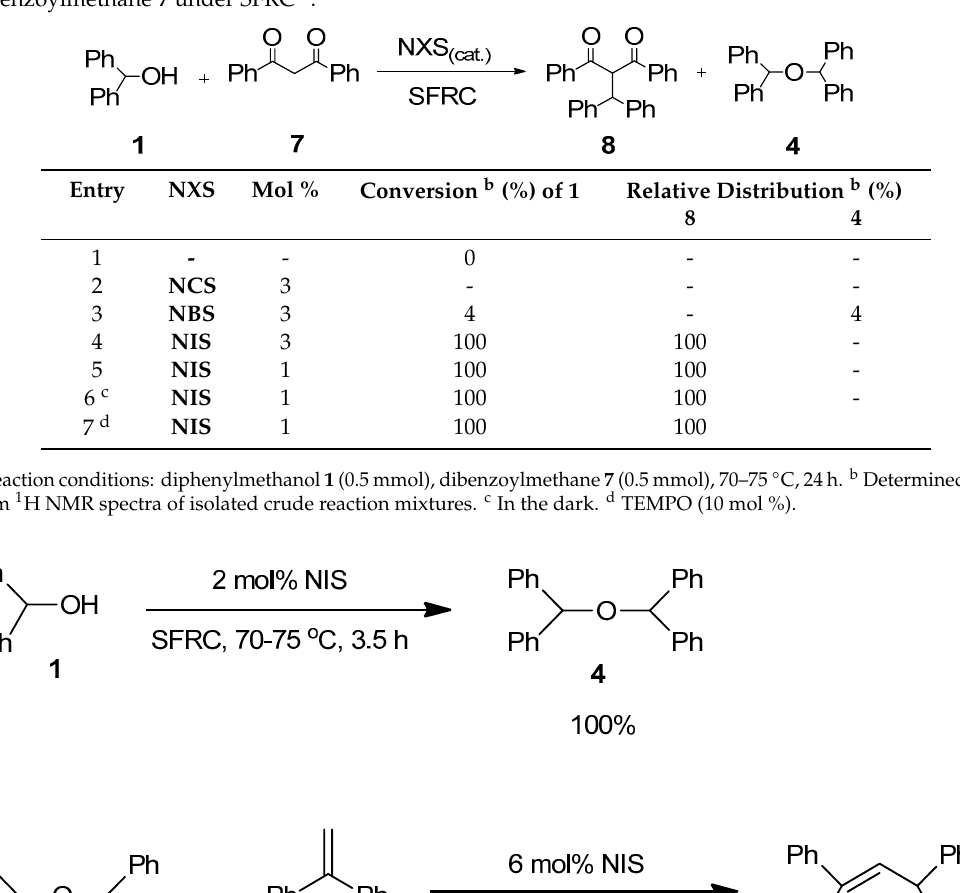
Table 2. The effect of substoichiometric amounts of NXS on conversion of diphenylmethanol 1 with dibenzoylmethane 7 under SFRC a .